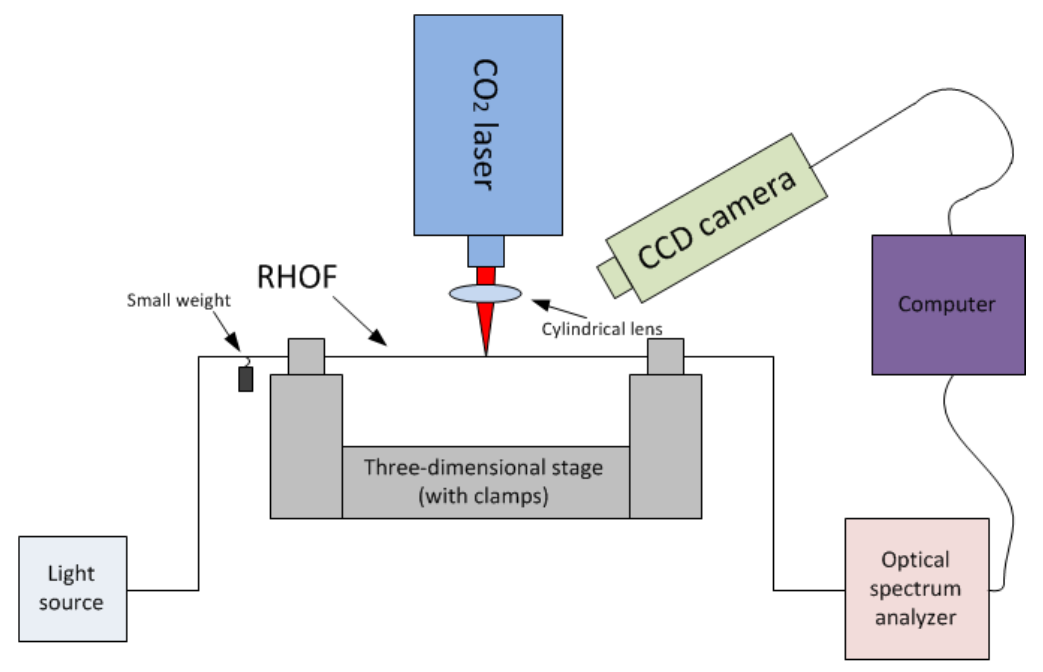
Figure 2. An illustration of the fabrication setup of the LPG written in the RHOF using a CO 2